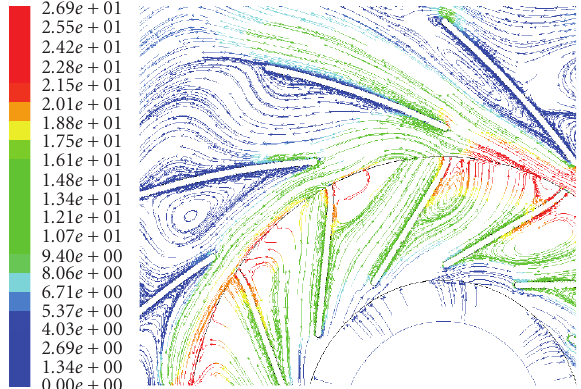
Figure 7: Relative velocity plot for configuration B (radial gap ratio =